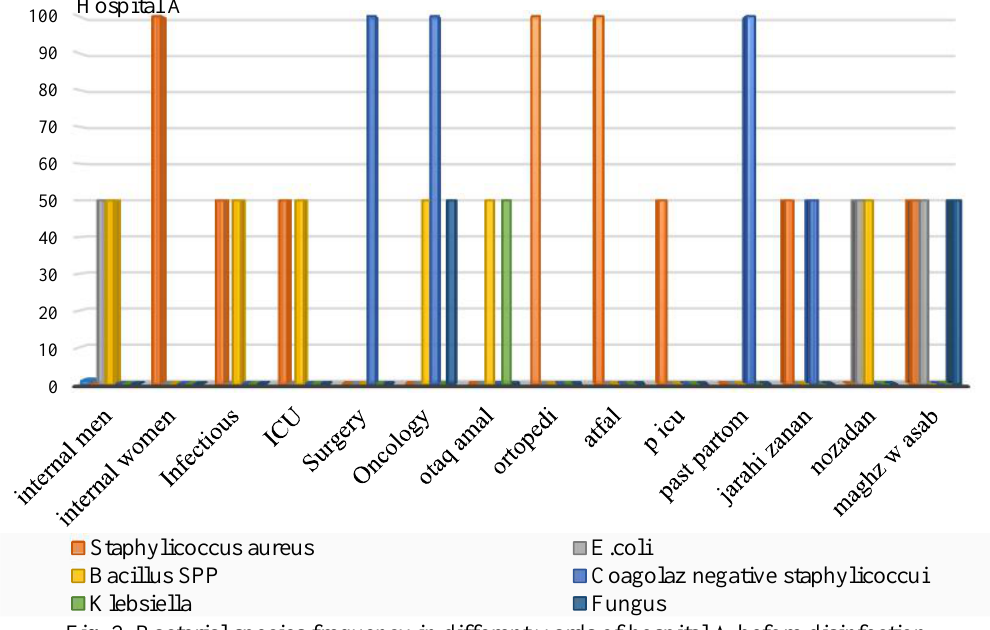
Fig. 2. Bacterial species frequency in different wards of hospital A before